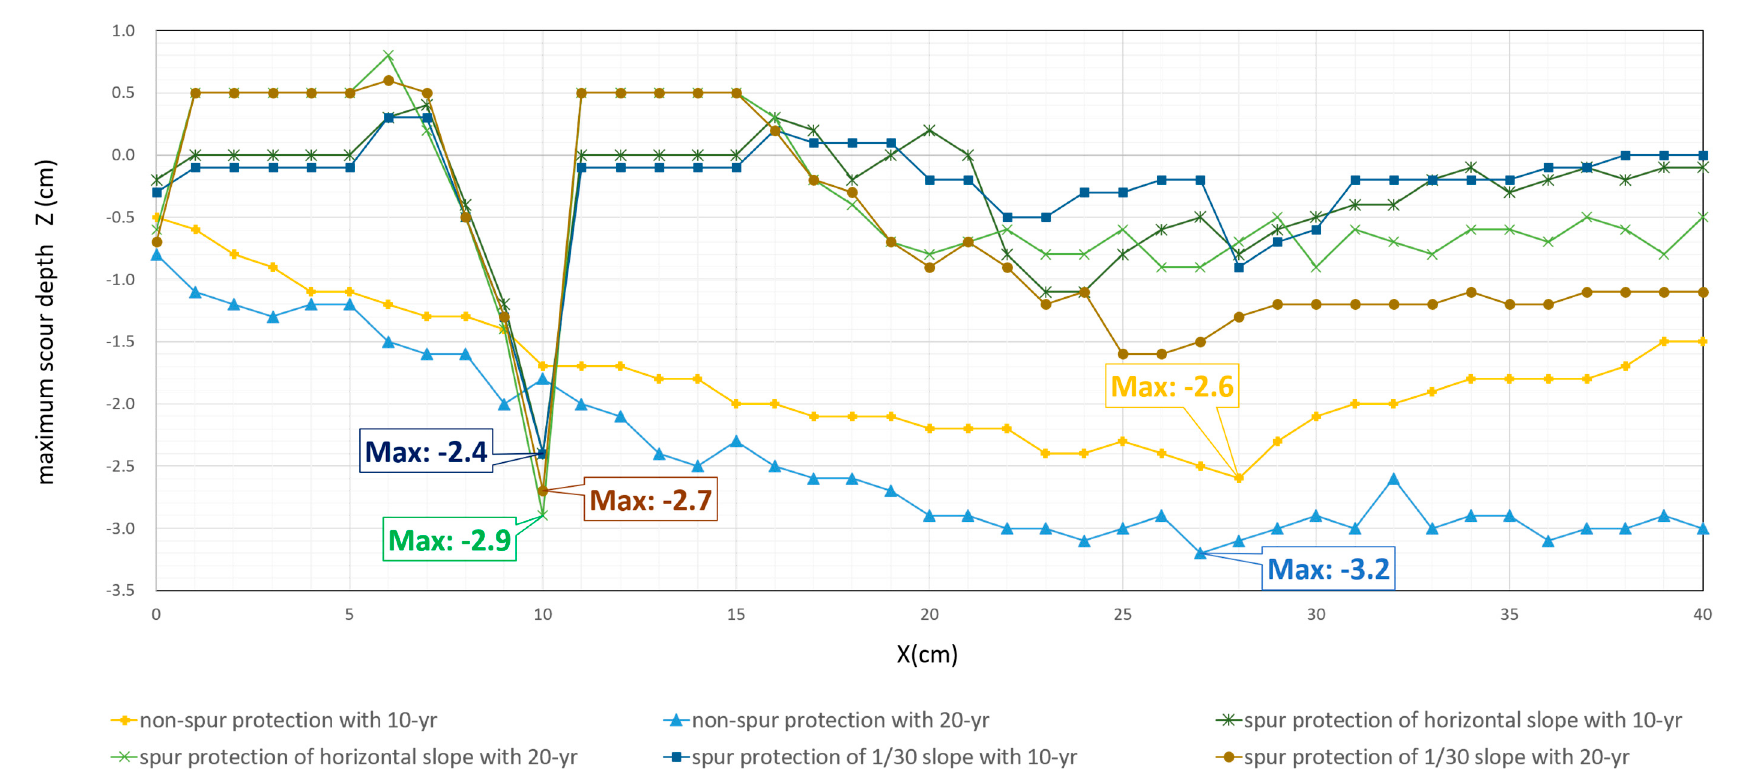
Figure 11. The maximum scour depth along the sections with spur and non-spur protections.